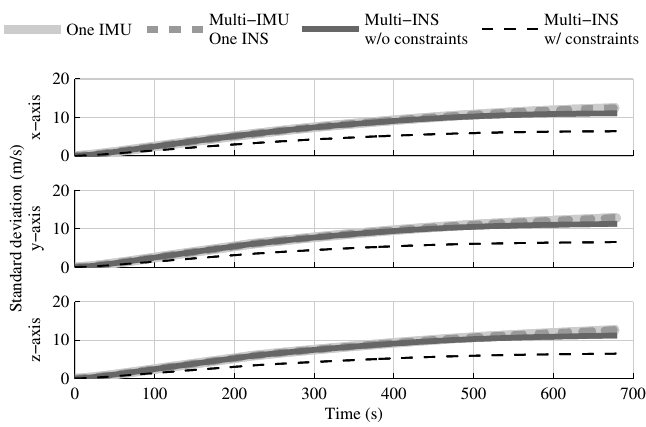
Figure 11. The velocity estimation error standard deviation obtained with the navigation solutions, when the GPS receiver is not